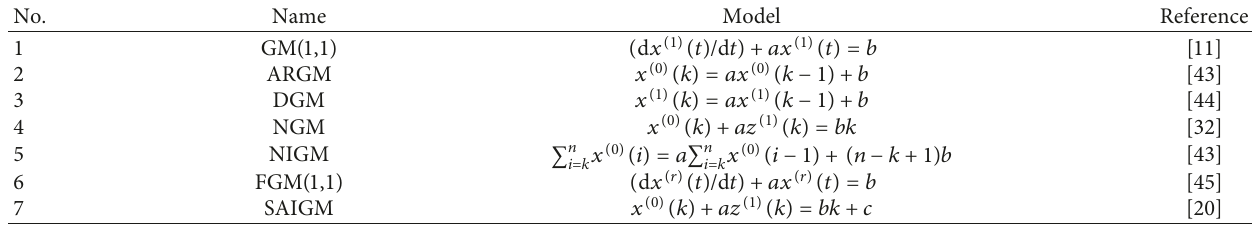
Table 1: The definition of the comparative grey models used.